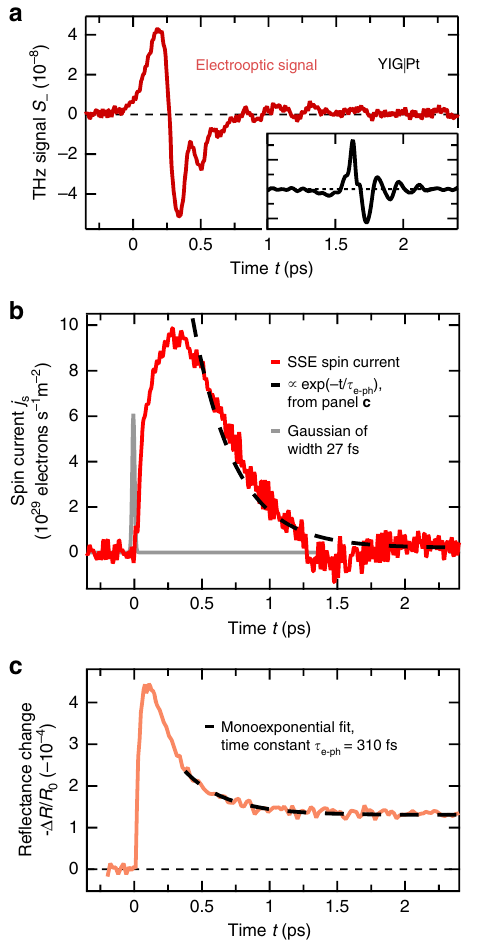
Fig. 4 Ultimate speed of the spin Seebeck effect. a THz signal S − ( t ) from a YIG(3 µ m)|Pt(5.5nm) bilayer measured using a 250 µ m thick GaP(110) electrooptic crystal. The inset shows the transfer function h ( t ) relating the electrooptic signal S − ( t ) to the THz electric fi eld directly behind the sample (Eq. (6)) and, thus, the spin current j s ( t ) within (Eq. (7)). Approximately, h ( t ) acts like a temporal derivative on j t ). b Extracted spin-current density s ( j t ) entering the Pt layer (red line). The gray line is a Gaussian with a full- s ( width at half maximum of 27 fs and visualizes an upper limit to the experimental time resolution (see Methods). The dashed black line is the monoexponential decay as obtained from the pump-induced sample re fl ectance of panel ( c ). c Pump-induced relative changes − Δ R ( t )/ R 0 in the re fl ectance of a Pt thin fi lm under excitation conditions similar to those used for measuring the THz emission signal of panel ( a ) (orange line). The dashed line is a fi t of a monoexponential decay plus an offset for t > 350 fs and yields a time constant of τ e − ph = 310